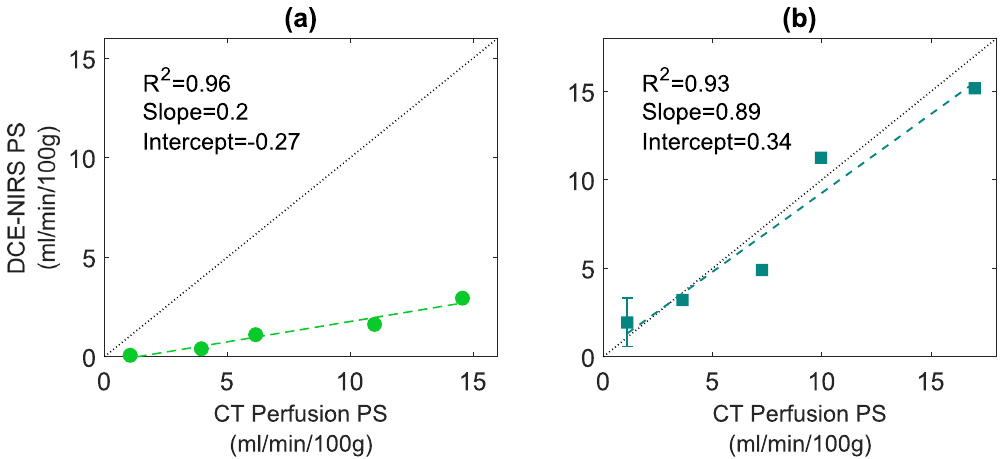
Figure 4. Regression analysis comparing PS values calculated for each of the optical dyes and the corresponding mean values determined by CT: ( a ) ICG data and ( b ) IRDye data. The dotted line in each graph represents the line of